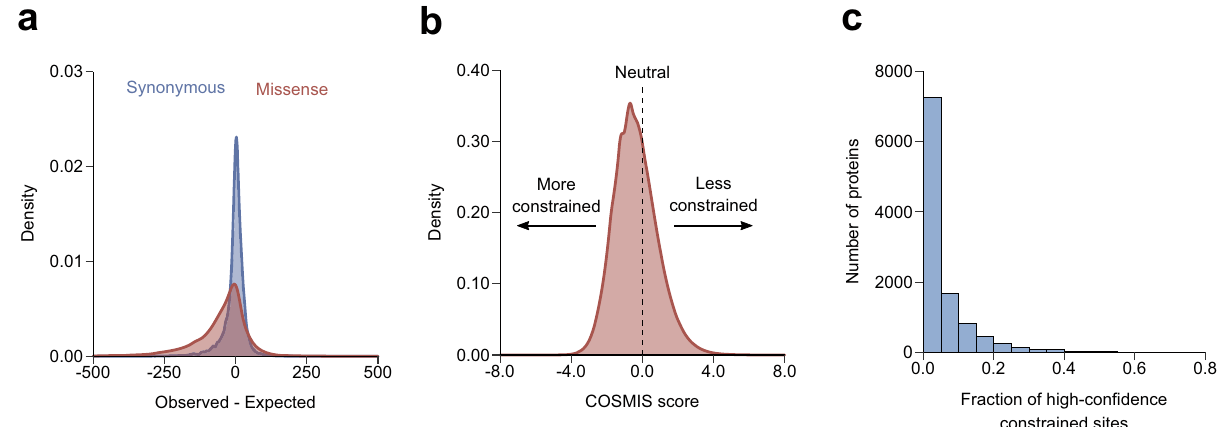
Fig. 3 The COSMIS score quanti fi es depletion of missense variants in contact sets. a Distribution of the deviation of the observed from the expected number of synonymous (blue) and missense (red) variants per-transcript computed from the mutability-aware model (Methods). The median of the deviation is roughly centered at zero (1.9) for synonymous variants but is signi fi cantly shifted towards negative values (more constraint) for missense variants (median − 29.1, p < 2 : 2 ´ 10 (cid:1) 308 , two-sided Mann – Whitney U test). b Distribution of the COSMIS scores for 6.1 million unique amino acid sites of the reference human proteome. As expected, an average amino acid site in the human proteome is depleted of missense variants in its contact set (median COSMIS score − 0.47) due to structural and/or functional constraint. c Distribution of per-protein fraction of high-con fi dence constrained sites (empirical p < 0.01). Source data are provided as a Source Data fi